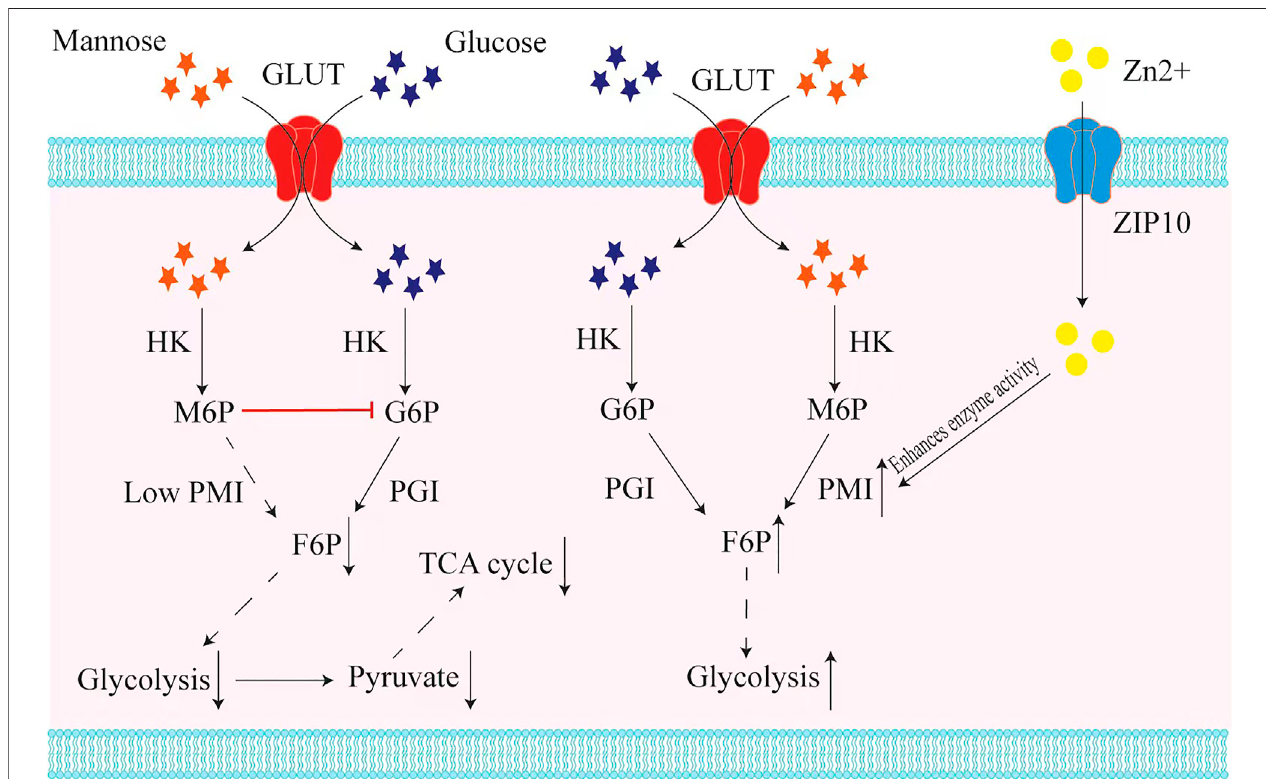
FIGURE1| MannoseinterfereswithglucosemetabolismintumorcellswithlowexpressionoftheMPIgene.Mannoseandglucosearetransportedintocellsbythe same transporter (GLUT), and transformed by hexokinase (HK) into mannose-6-phosphate (M6P) and glucose-6-phosphate (G6P). In those tumor cells with low mannose phosphate isomerase (MPI) expression, the accumulation of M6P suppresses glucose phosphate isomerase (GPI) and other enzymes related to glucose metabolism, resulting in inhibition of glycolysis and in turn inhibition of the tricarboxylic acid cycle (TCA). In contrast, in tumor cells that express a high level of MPI, mannose could be used for glycolysis ef fi ciently. Recent studies have found that Zn 2+ is crucial for mannose phosphate isomerase (PMI) to exert enzymatic activity, and when ZIP10, a transporter of Zn 2+ , is knocked down, it causes the inactivation of MPI and makes tumor cells become mannose sensitive.